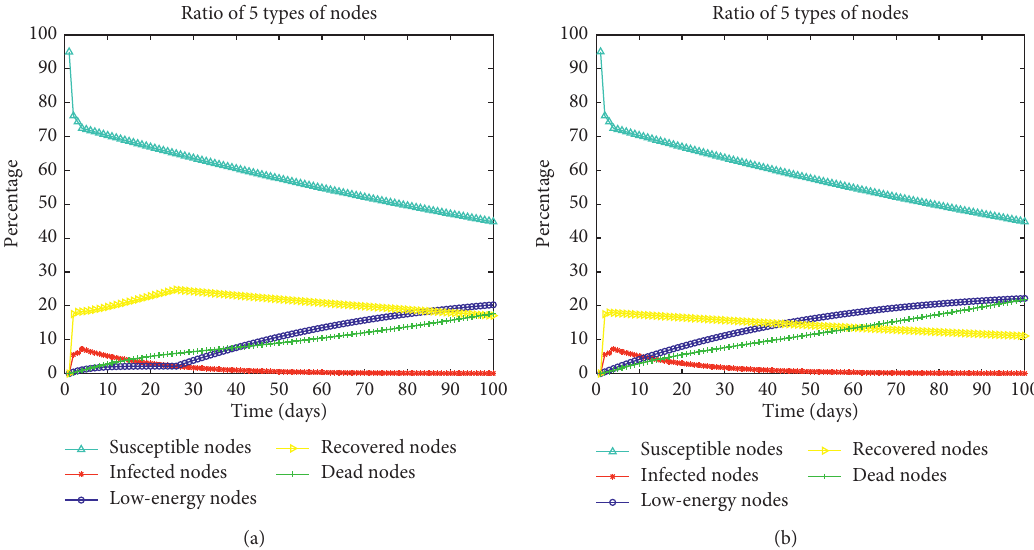
Figure 3: Evolution of five types of nodes. In order to emphasize the impact of charging, this experiment takes charging as a research factor. (a) The evolution of nodes under the condition of charging (i.e., with energy inputs). (b) The evolution of nodes under the condition of no charging (i.e., without energy input).